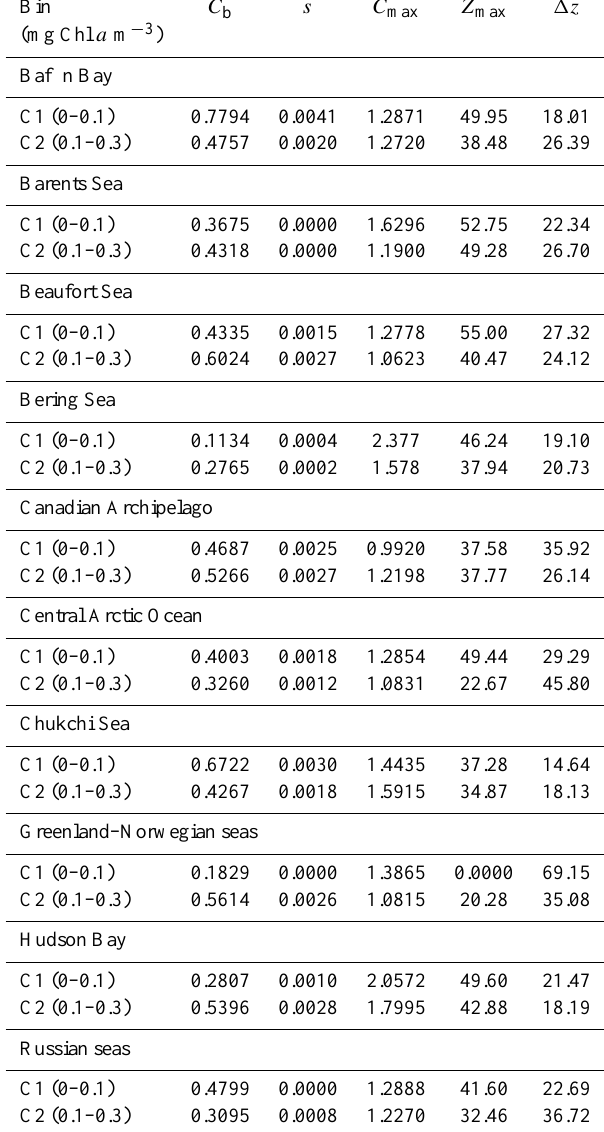
Table 4. Estimated values of the five parameters of Equation 1, obtained for the average dimensionless vertical profiles of chloro- phyll a (C1–C2) at deep ( > 50m) stations of each sub-Arctic and Arctic seas during the post-bloom period